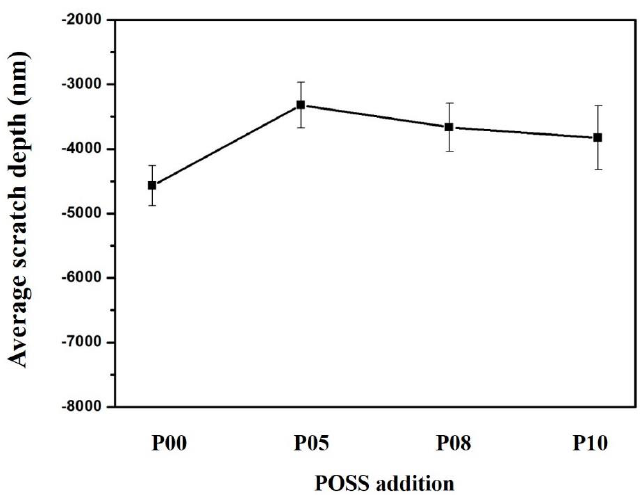
Figure 5. Average scratch depth of composite resins with different POSS additions.